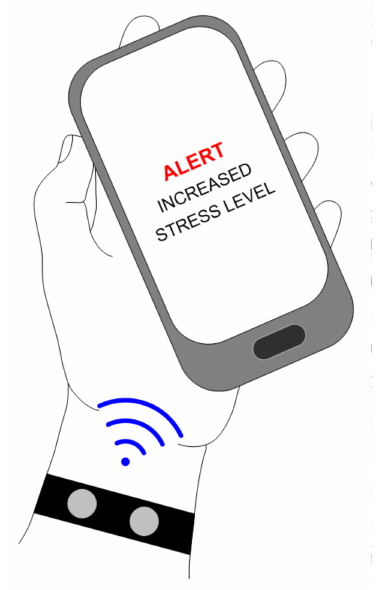
Figure 3. Exemplification of stress level increase alerting by a smartphone